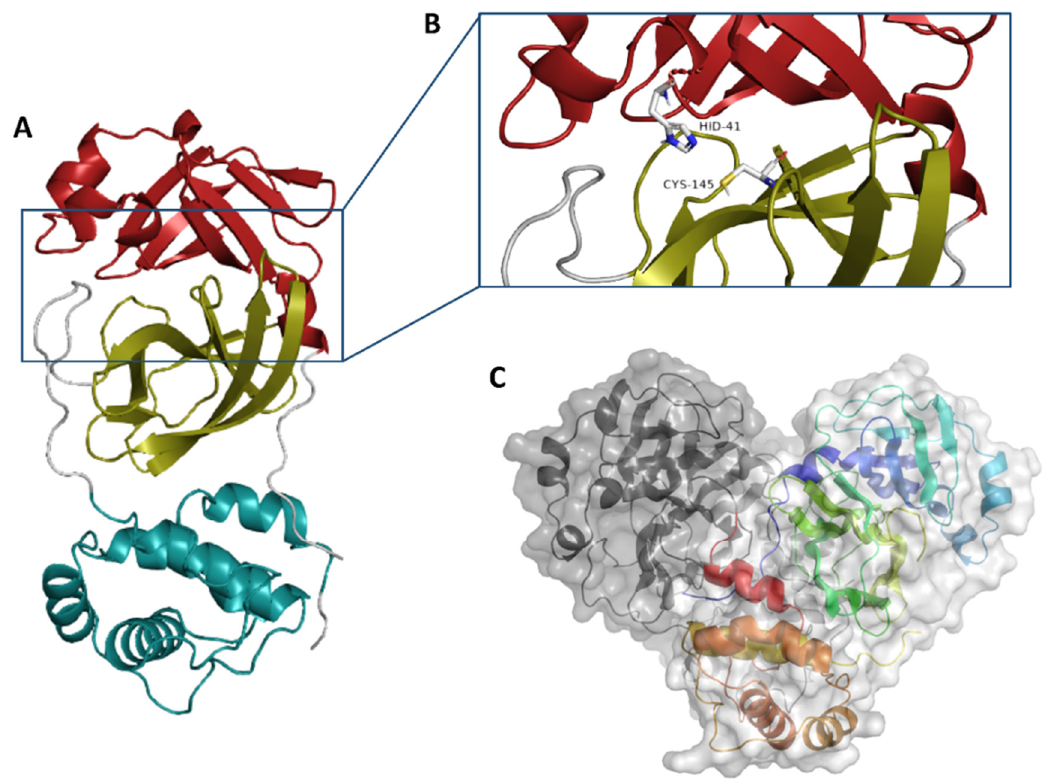
Figure 1. Monomeric structure of SARS CoV-2 M pro (PDB code: 6LU7) showing its three main domains (I, II, and III; red, golden yellow, and cyan blue, respectively ( A ). M pro active site showing the catalytic dyad (HID41-CYS145) ( B ). The dimeric active form of SARS CoV-2 M pro ( C ).